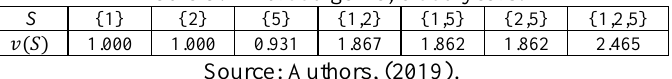
Table 3: 21-brood game, Good years.